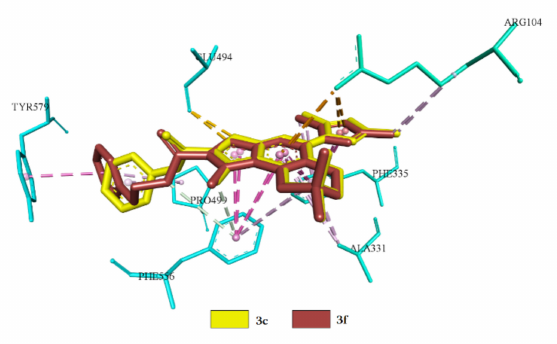
Figure 9. Superpositions of 3c, 3f in the central site of the active center of SERT.